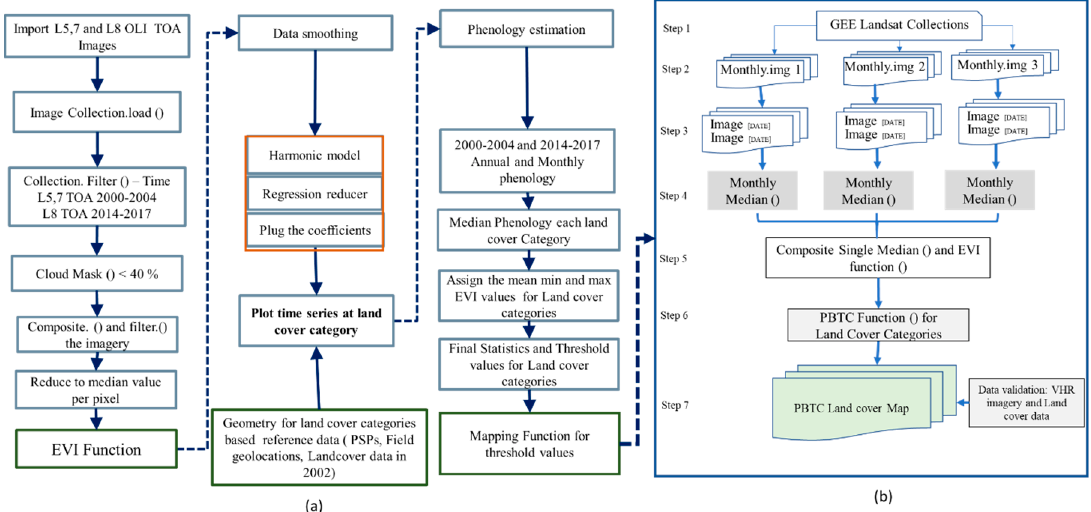
Figure 3. ( a ) Flowchart of the research methodology adopted to estimate phenology and determine the thresholds for selected land cover categories in this study, and ( b ) methods used for single composite image pixel-based threshold classification using the GEE cloud-computing platform with basic machine learning algorithms.